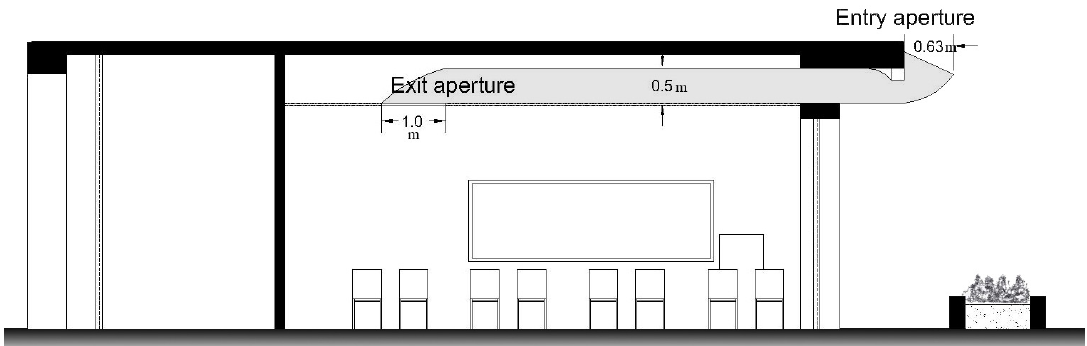
Figure 10. Section in a typical classroom showing the suggested northern anidolic ducts.